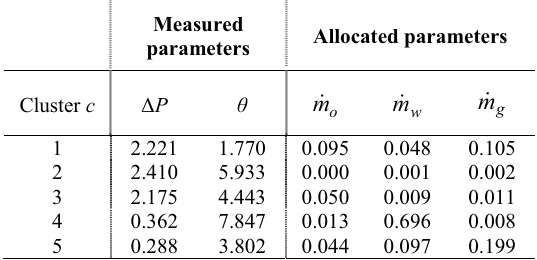
algorithm for determining the C optimal